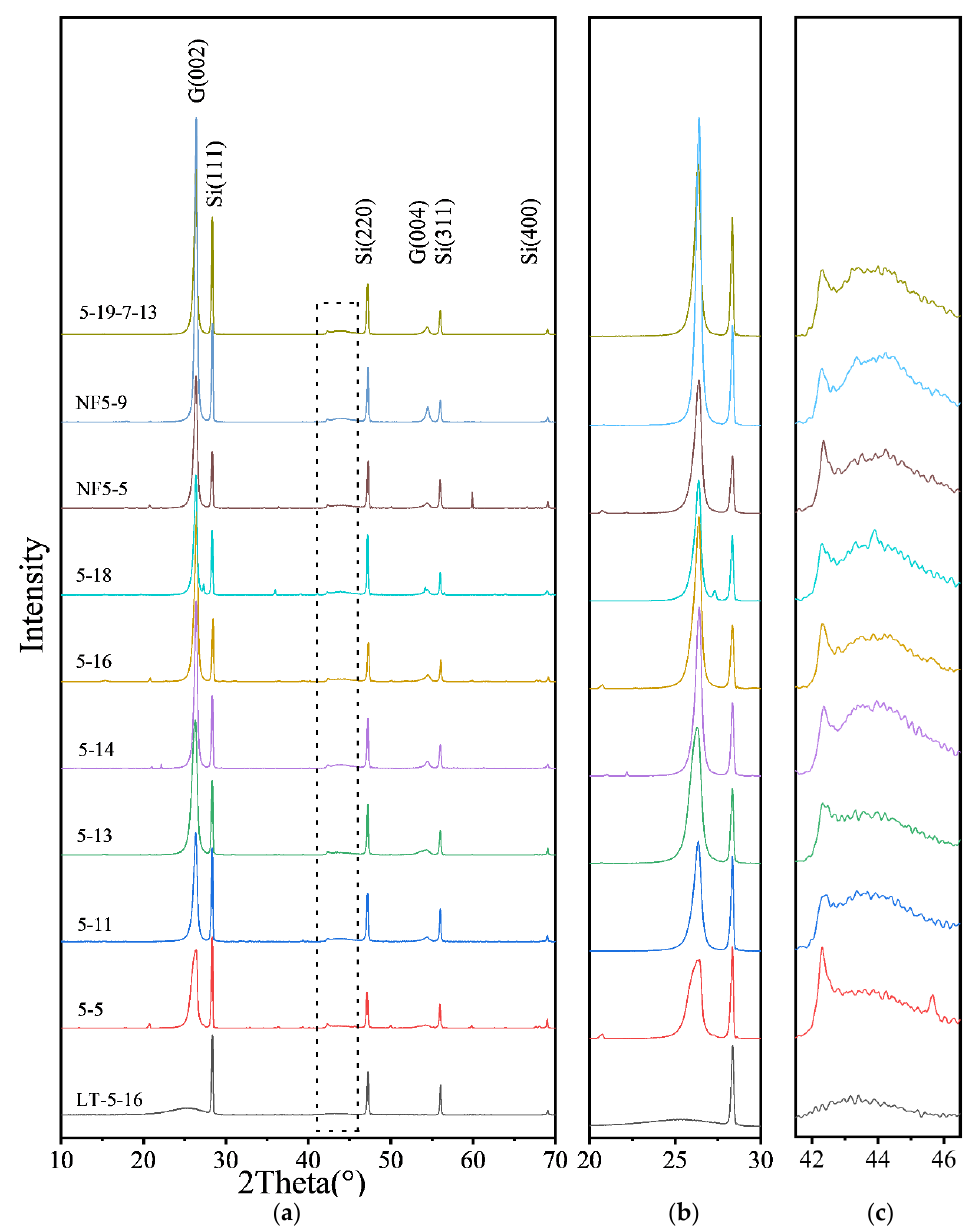
Figure 3. XRD patterns of coal seam-derived graphite in 2 θ ranges ( a ) between 10° and 70°, ( b ) between 20° and 30°, and ( c ) between 42° and 46°. Table 2. XRD parameters and optical reflectance of samples.